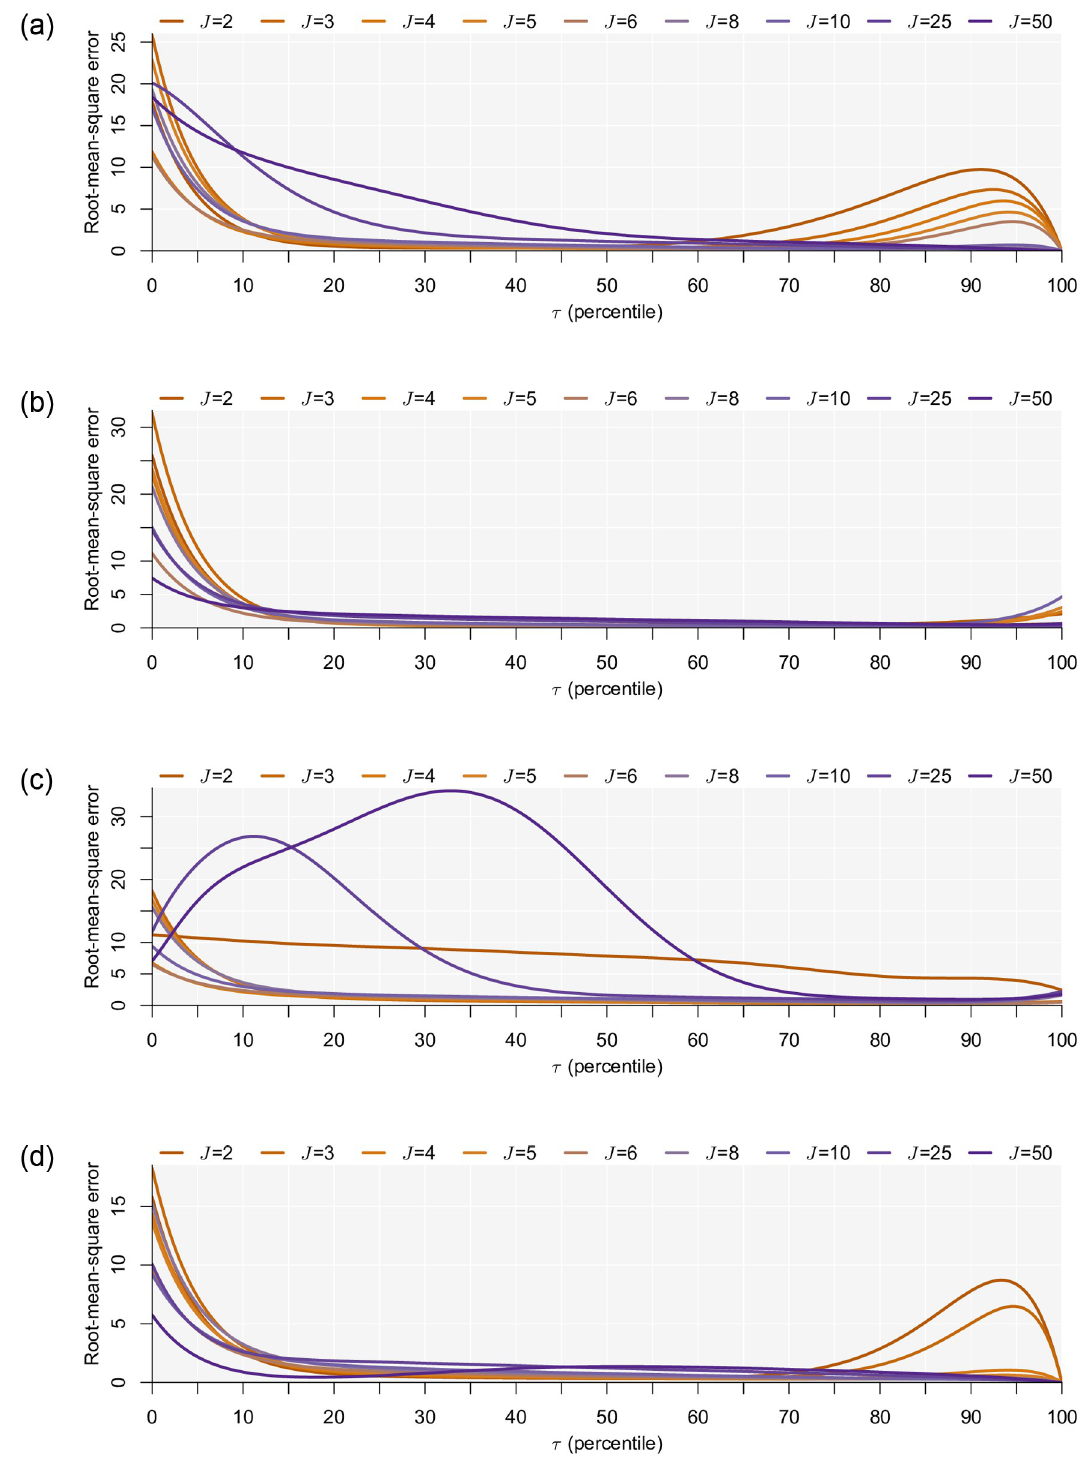
Fig 3. Accuracy of ^ τ . (a) Data generated on basis of choose the utility maximizing alternative secondary decision rule. (b) Data generated on basis of choose the opt-out alternative secondary decision rule. (c) Data generated on basis of choose the last alternative secondary decision rule. (d) Data generated on basis of choose a random alternative secondary decision rule.